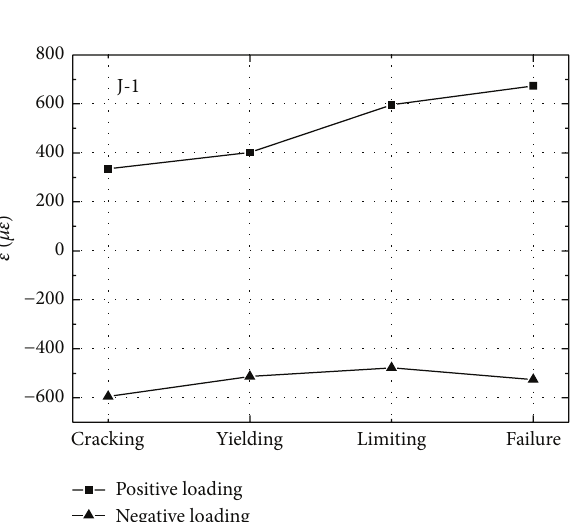
Figure 17: Strain of column hoop.